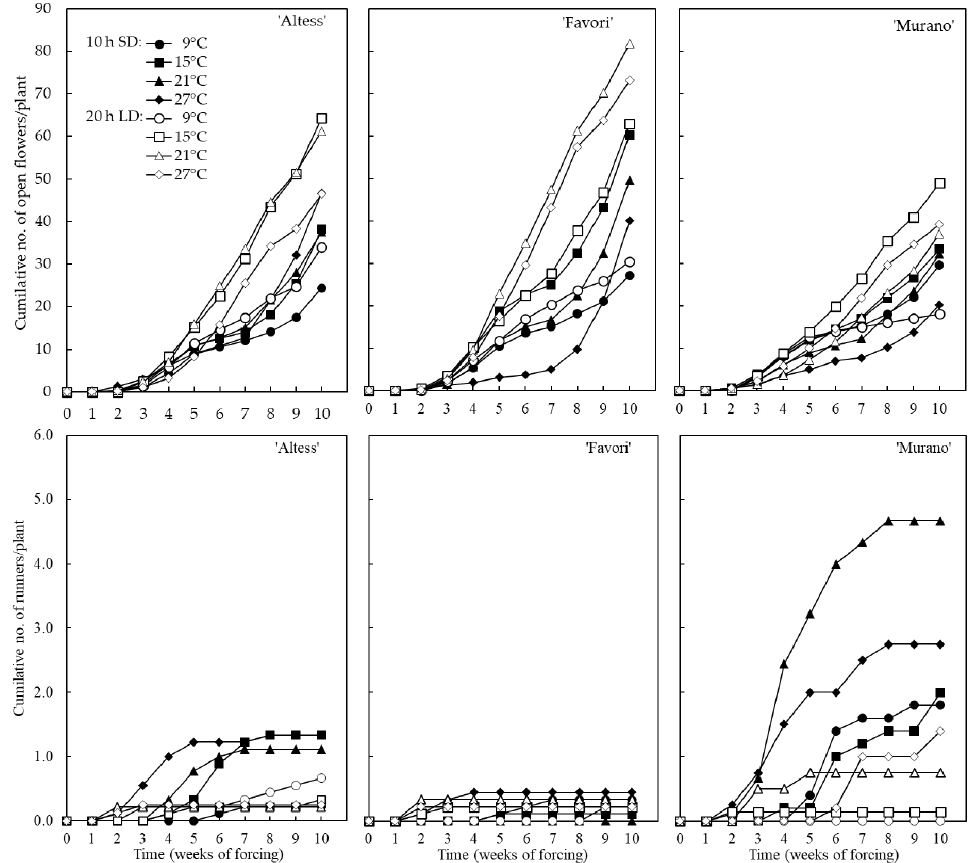
Figure 3. Time courses of cumulative flower (top panel) and runner formation in three EB strawberry cultivars as affected by 4 weeks of temperature and photoperiod preconditioning, as indicated during 10 weeks of subsequent forcing in a greenhouse in 20-h LD at 20 °C. The data are means of three replicates, each with three plants of each cultivar.